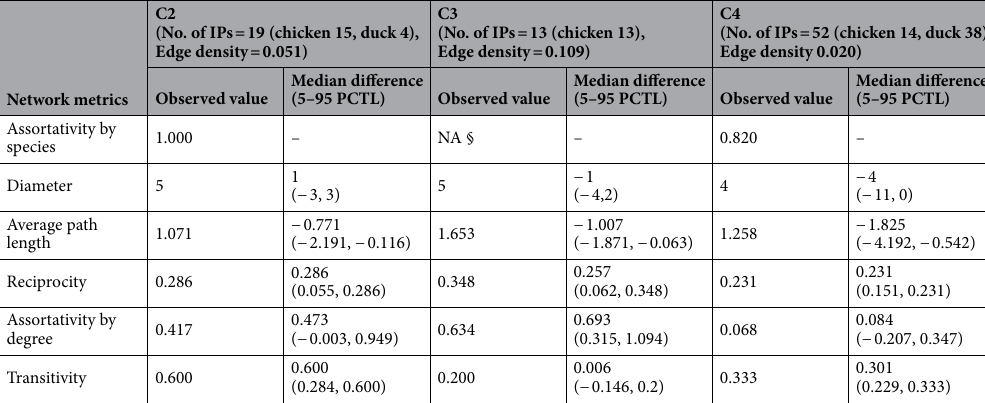
Table 4. Permutation test of contact network structure metrics between the same genotype of HPAI H5N6 virus infected premises linked via vehicle movements based on the Bayesian parameter estimation. Networks for permutation test were generated based on the observed number of IPs (nodes) and probability of edge formation between nodes, which was calculated by the observed edge density. MD, median difference between observed value and 1000 simulated values; 5–95 PCTL 5–95% percentile range of difference. NA, not available; because all IPs were chicken holdings, the corresponding assortativity were not available. Diameter is the shortest distance between the two most distant nodes in the network. Average path length is equal to the number of ties along the shortest length of the tie between two nodes. Reciprocity denotes the proportion of nodes in a directed network to be mutually linked. Transitivity refers to the ratio between the observed closed triplets and the maximum possible number of closed triplets in the network. HPAI, highly pathogenic avian influenza; IPs, infected